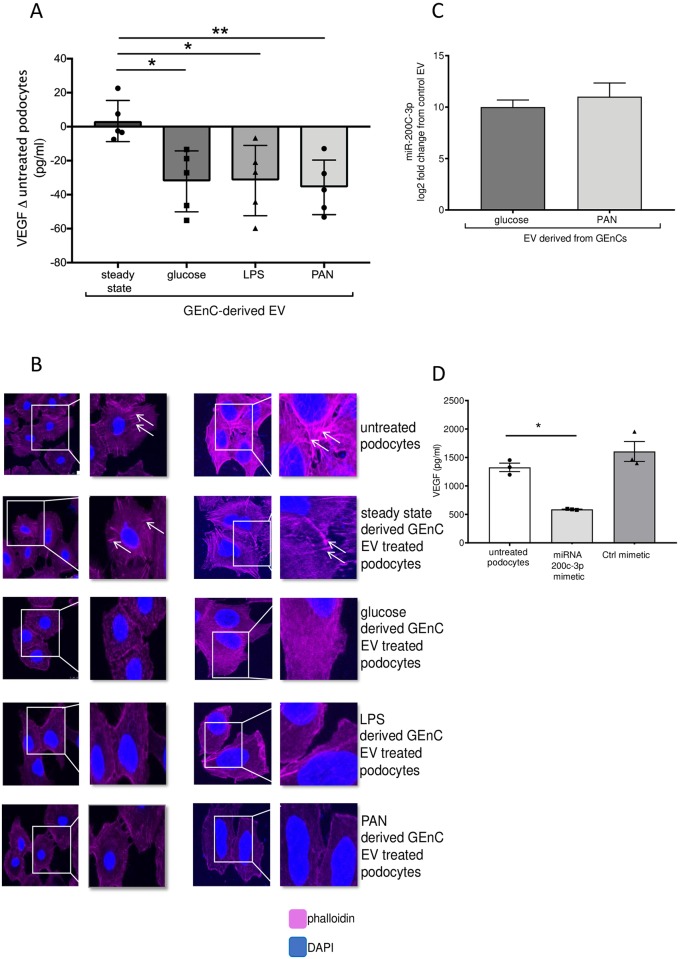
Extracellular vesicles derived from activated GEnC mediate podocyte dysfunction—A role for miRNA-200c-3p.A) Podocytes were treated for 24 hrs with EV from steady state GEnC, glucose treated GEnC, LPS treated GEnC or PAN treated GEnC and VEGF secretion measured by ELISA. Presented as change from untreated podocytes (steady state). n = 6. B) Representative images of actin microfilaments detected using phalloidin staining with fluorescence microscopy. Nuclei were stained with DAPI. Podocytes were treated for 24 hrs with EV from steady state GEnC, glucose treated GEnC, LPS treated GEnC or PAN treated GEnC. Scale bar represents 25μm. Arrows indicate stress fibres during steady state. C) Increased expression of miRNA-200c-3p in podocytes treated with EV derived from GEnC treated with glucose or PAN versus podocytes treated with steady state GEnC derived EV (from miRNA sequencing) D) Effect of miR-200c-3p transfection on podocyte VEGF sprotein expression as measured by ELISA. Negative control mimic was used as a control. n = 3. *, ** and *** represents P<0.05, P<0.01,P<0.001 respectively, groups were compared using an unpaired t-test.